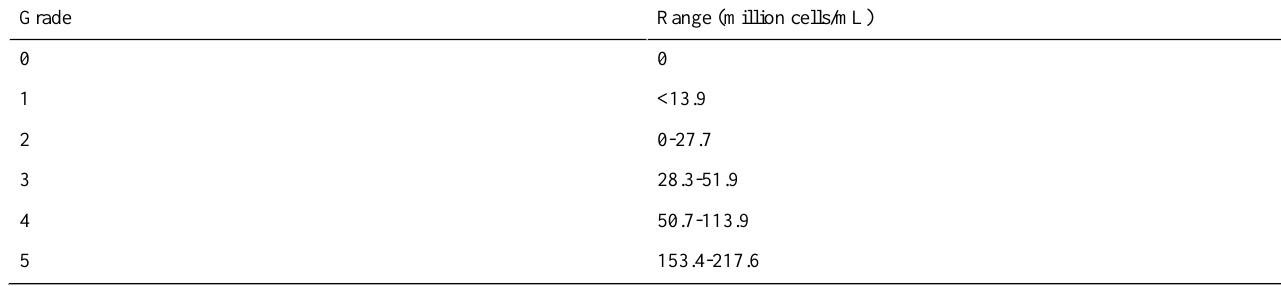
Table 2. Calibrated reference values of sperm